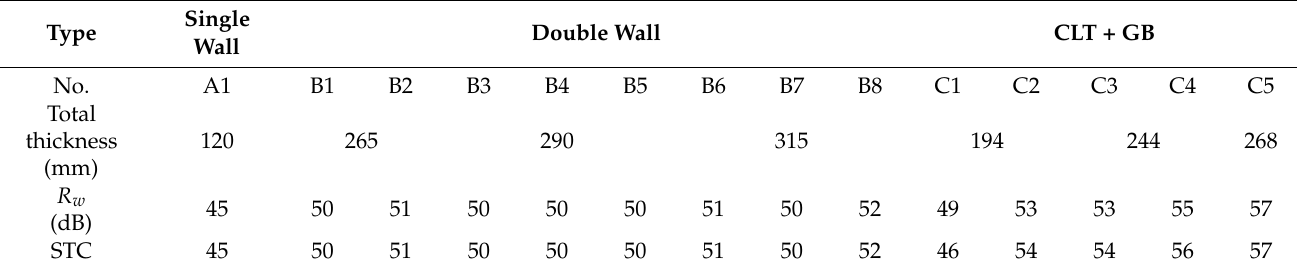
Table 3. The results of sound insulation